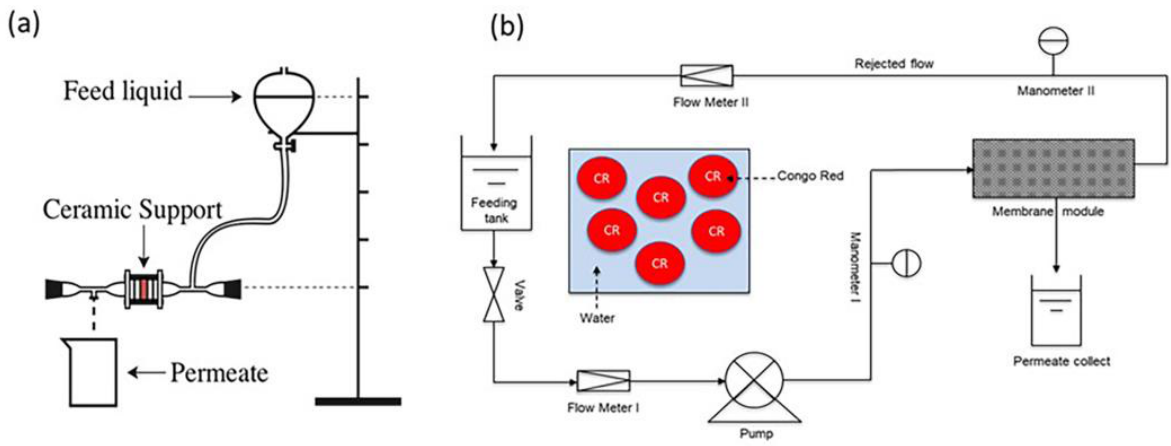
Figure 3. ( a ) Scheme of the laboratory apparatus for the permeability test; ( b ) schematic for the CR separation system with the GO/ceramic membrane.